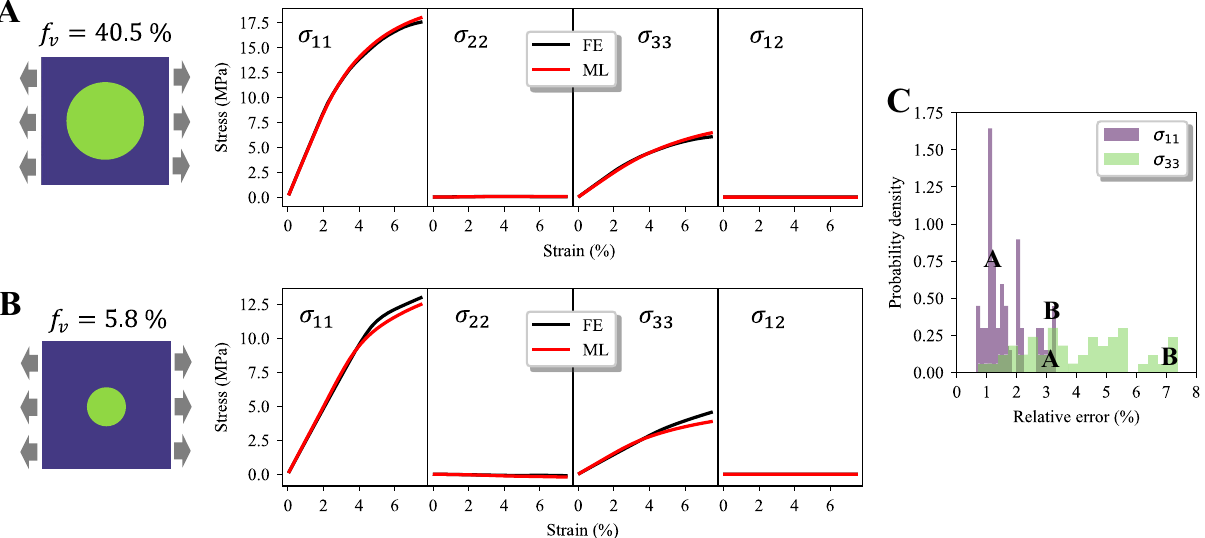
Figure 3. Derivative macroscopic material response from the GNN-predicted stress field evolution of unidirectional fiber composites. Stress–strain curves derived from ML-predicted and FE-simulated fields for f v = 40.5 % ( A ), and f v = 5.8 % ( B ). ( C ) Mean relative error distributions evaluated on the test dataset for